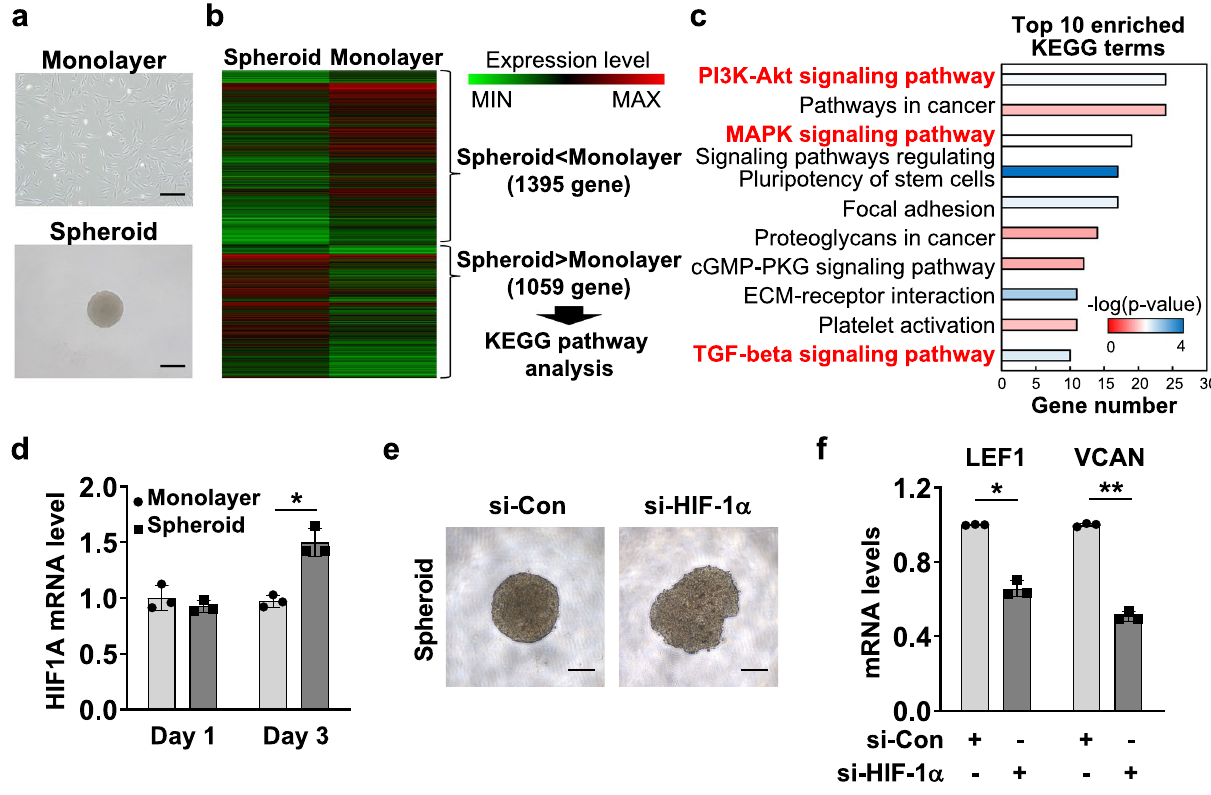
Figure 3. Three-dimensional (3D) culture of DPCs shows high expression of HIF1A, and HIF-1α regulates trichogenic genes in DPC spheroids. (a) Representative images of monolayer cultured or three-dimensionally cultured DPCs. (b) Gene chip analysis was conducted with monolayer cultured DPCs and DPC spheroids. A total of 1059 genes (upregulated in DPC spheroids compared to monolayer cultured DPCs, threshold of Log 2 FC > 1) were selected for Kyoto Encyclopedia of Genes and Genomes (KEGG) pathway analysis. (c) The list of top enriched KEGG pathways. (d) Total RNA from monolayer cultured DPCs or DPC spheroids was extracted and then subjected to RT ‒ qPCR to determine HIF1A mRNA levels (mean ± SD, n = 3). (e,f) DPCs were treated with si-Con or si-HIF-1α for 48 h and subsequently utilized for spheroid organization ( e ). LEF1 and VCAN mRNA levels were measured using RT ‒ qPCR ( f ). The data are presented as the means and SD calculated with data from 3 independent